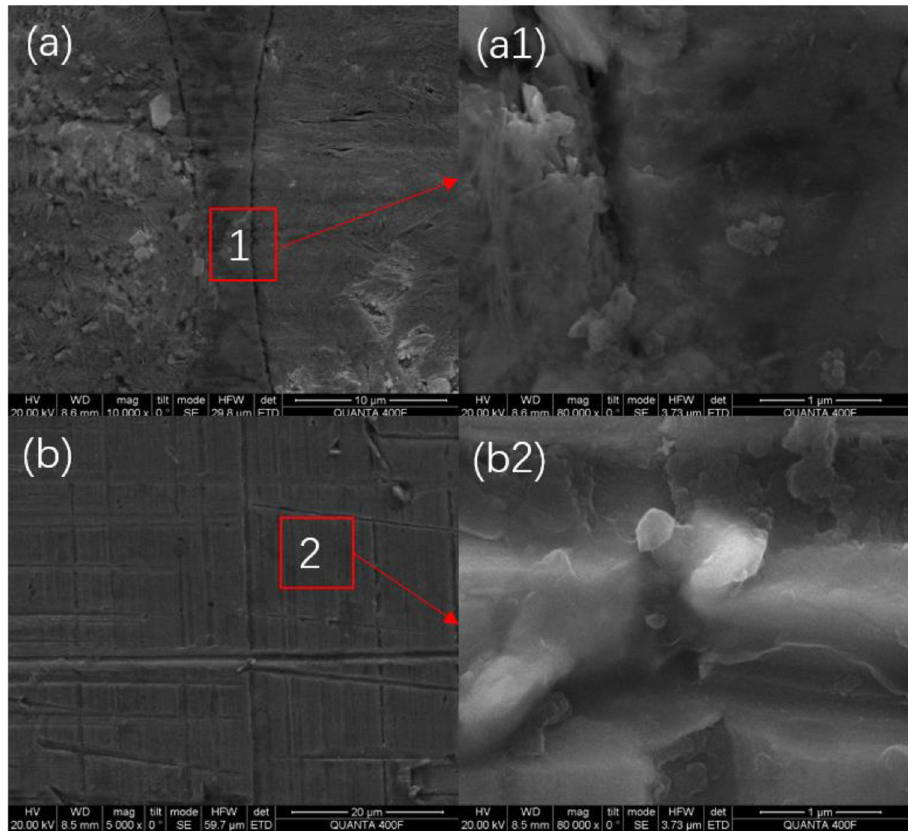
Figure 12: Low ( a, b ) and high ( a1, b2 ) magni fi ed surface corrosion SEM images of Ni/WC coating exposed to 3.5 wt% NaCl solution for 30